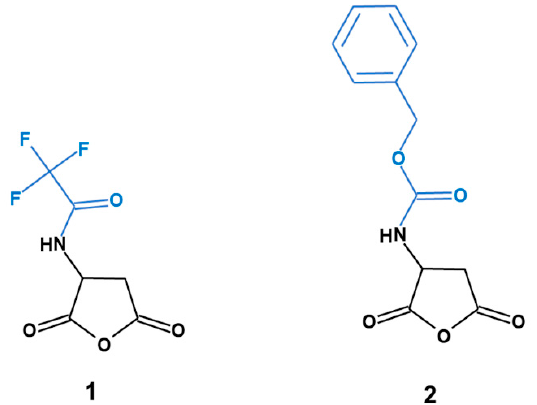
Figure 7. Aspartic anhydrides with N-protective group: 1 ) Trifluoroacetyl (TFAc) and 2 ) carbobenzyloxy (Cbz).